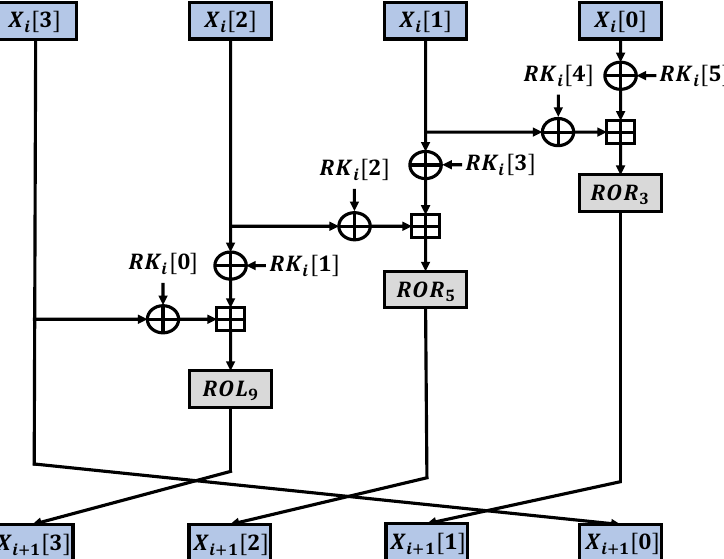
Figure 2. LEA round function [1] ( RK : round key, ROR 3 , ROR 5 , and ROL 9 : rotate